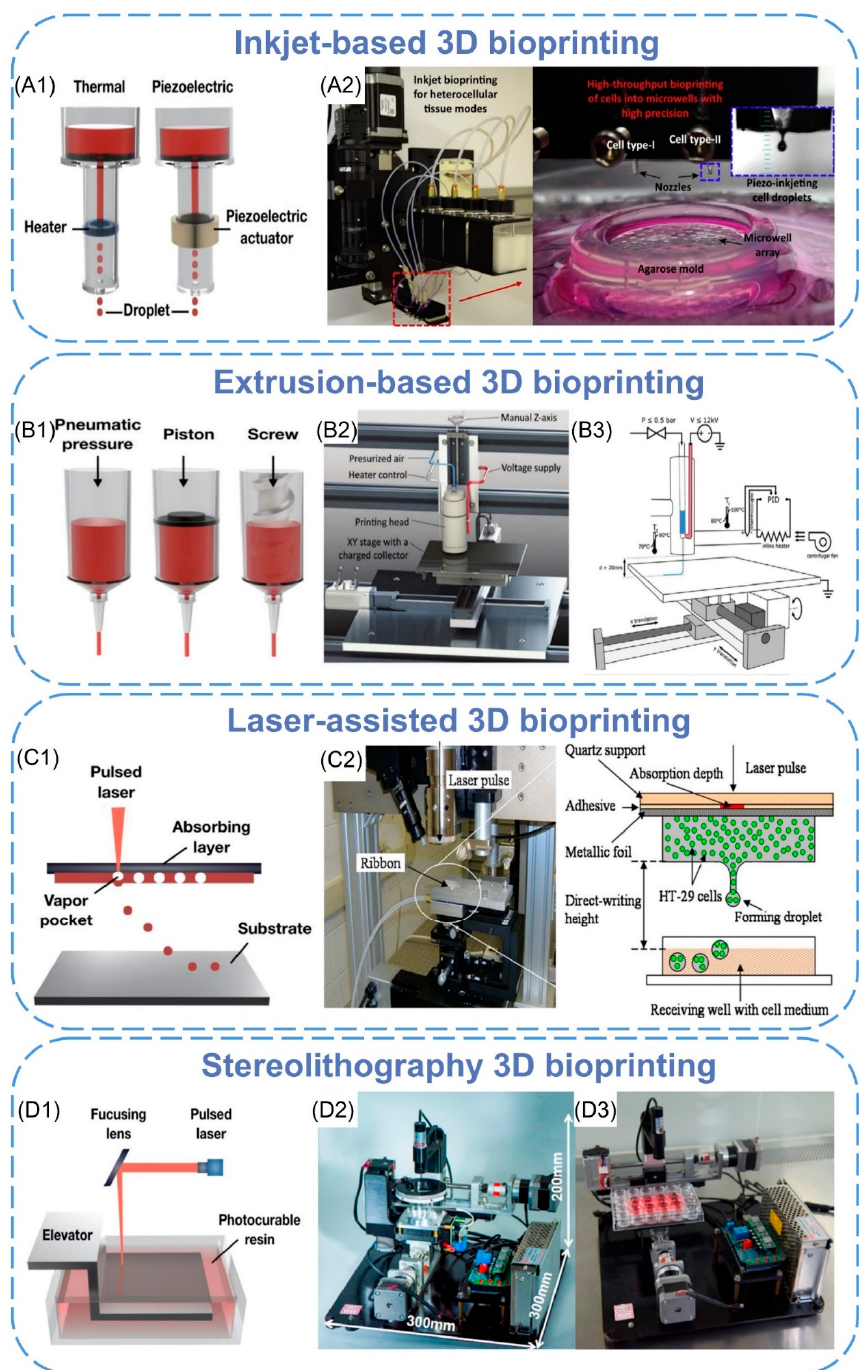
Figure 4. Bioprinting principles and devices. ( A1 ) The mechanism diagram of the inkjet 3D bioprint ‐ ing [85] . Copyright 2020, MDPI. ( A2 ) A high ‐ resolution inkjet ‐ based bioprinter for fabrication of